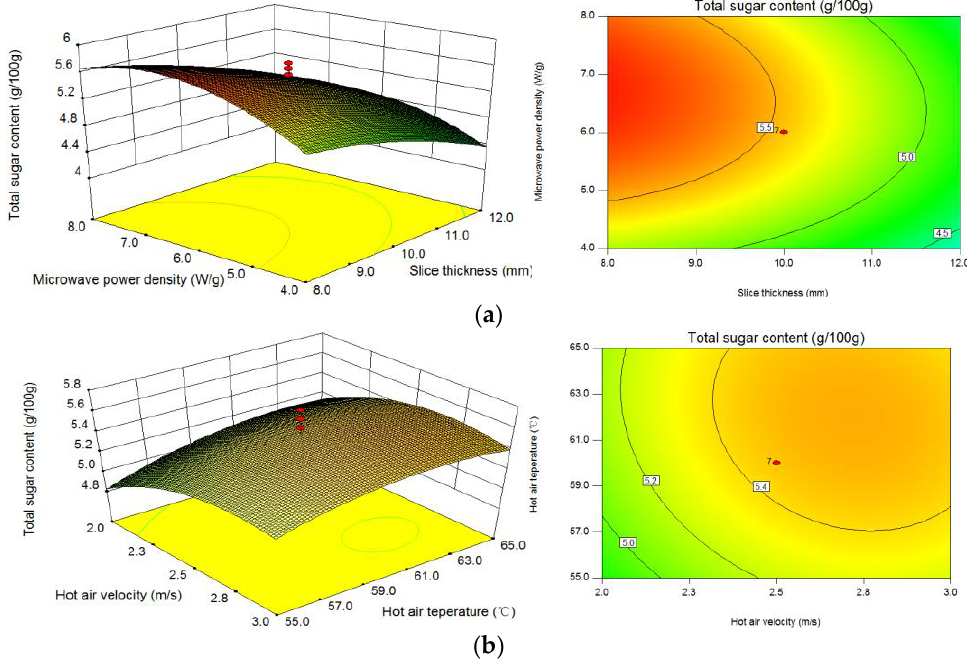
Figure 5. Response surface plots of TSC between variables. ( a ) Slice thickness and microwave power density; ( b ) Hot air velocity and hot air temperature.